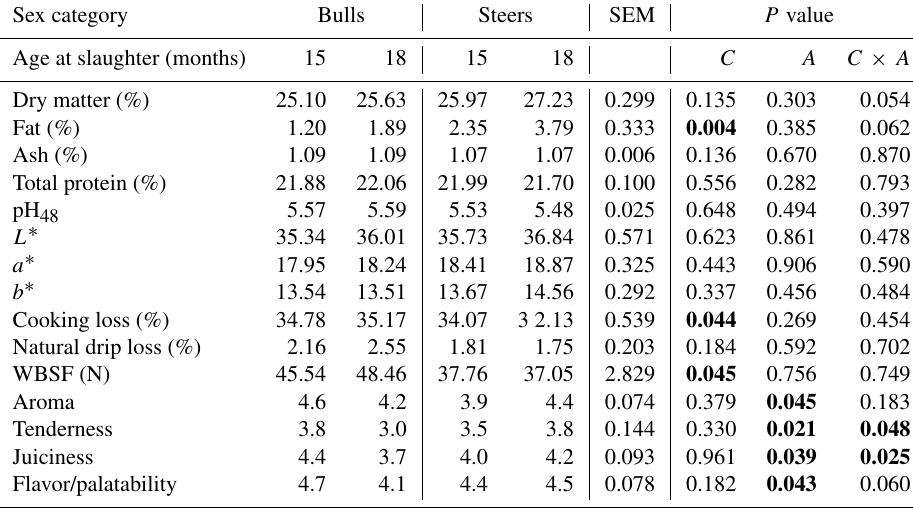
Table 5. Chemical composition, physical properties and sensory properties of m. longissimus thoracis. Sex category Bulls Steers SEM P value Age at slaughter (months) 15 Dry matter (%) 25.10 25.63